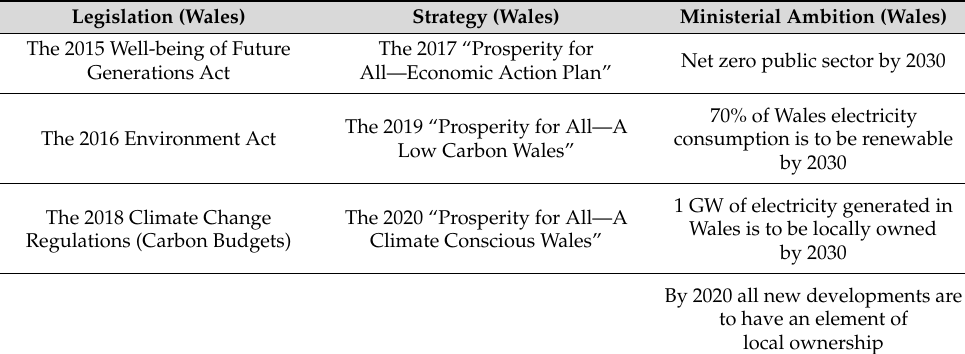
Table 2. Wales Decarbonisation Strategic Delivery Plan illustrating the Welsh government legislative and strategic structure for climate action